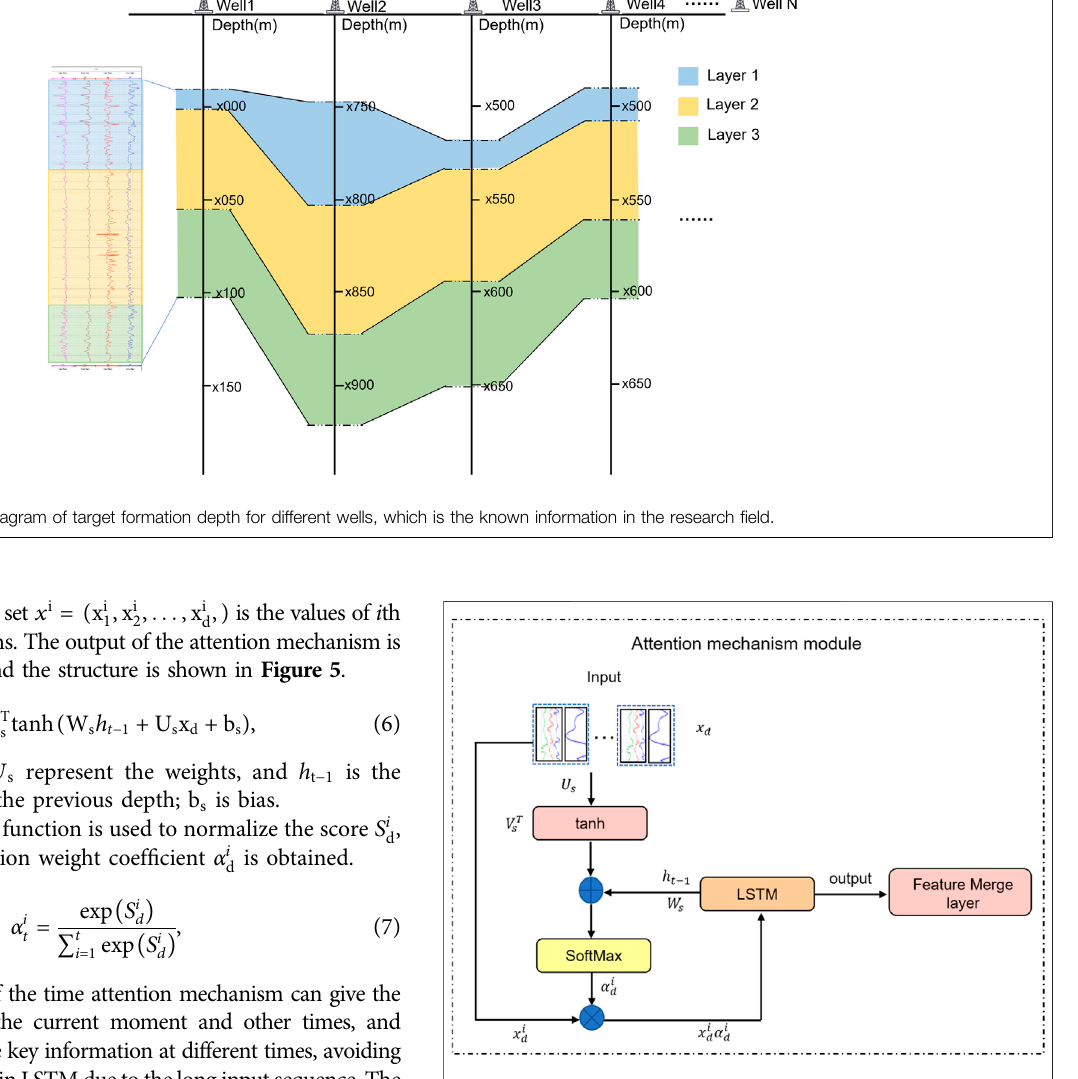
t − 1 is the hidden layer state at the previous depth; coef fi cient, and x i d is input log sequence.